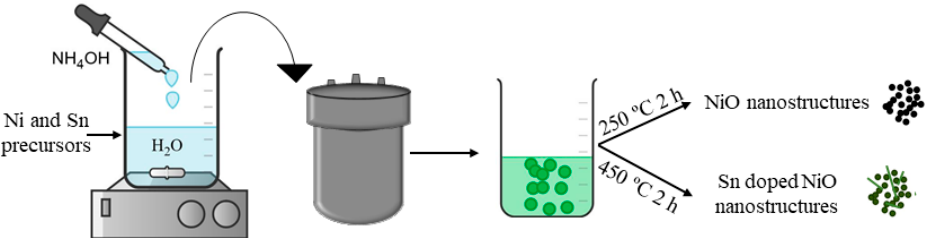
Figure 1. Schematic illustration of the experimental method employed to obtain undoped and Sn doped NiO.